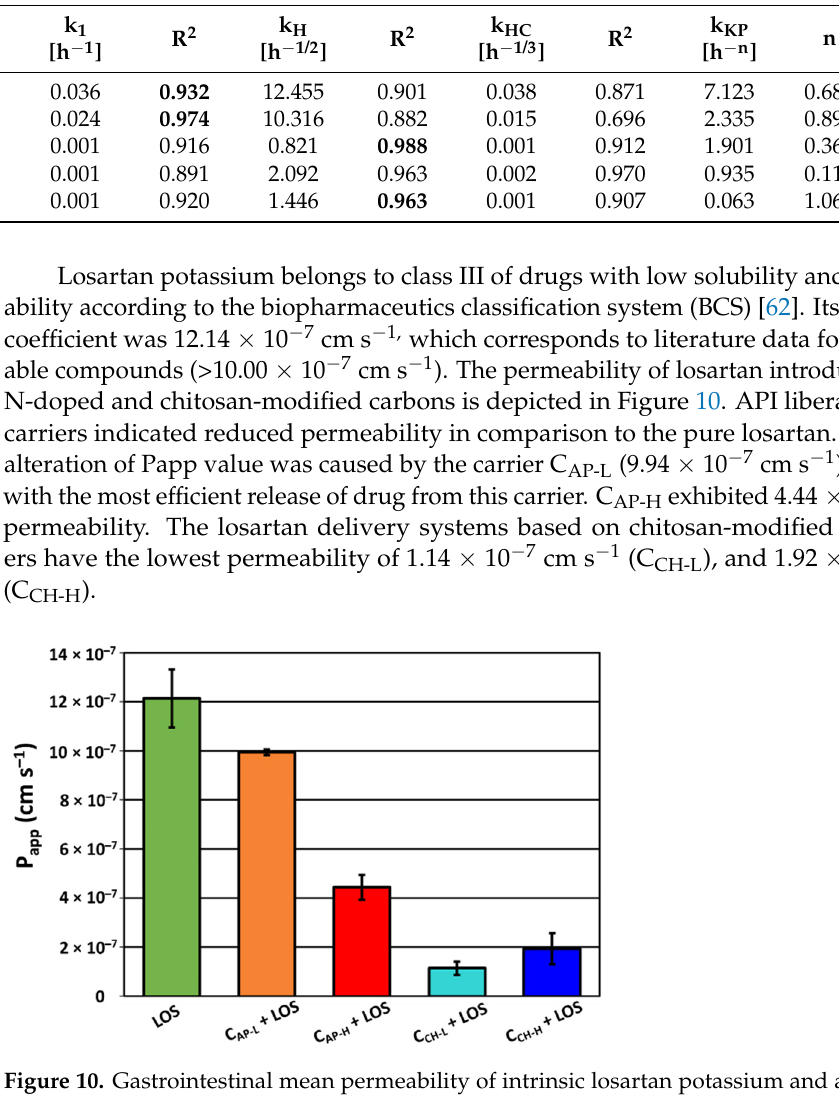
Table 4. Parameters of kinetic release models suggesting the mechanism of diclofenac liberation from carbon vehicles. Material